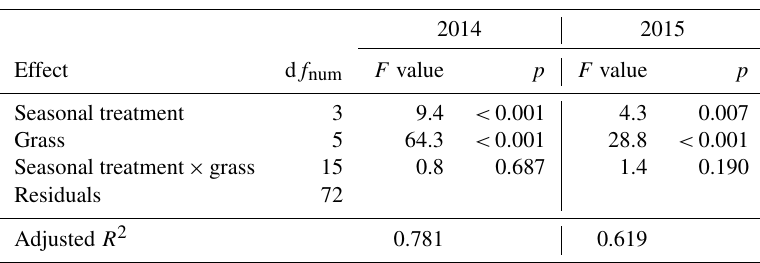
Table A2. Summary of the analysis for the effects of seasonal treatment, grass and their interaction on cumulative annual aboveground biomass production (i.e., annual